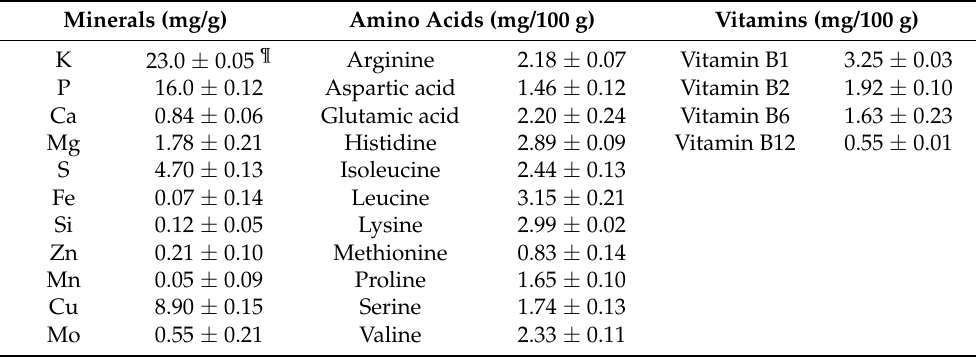
Table 1. The nutritional contents of the yeast extract